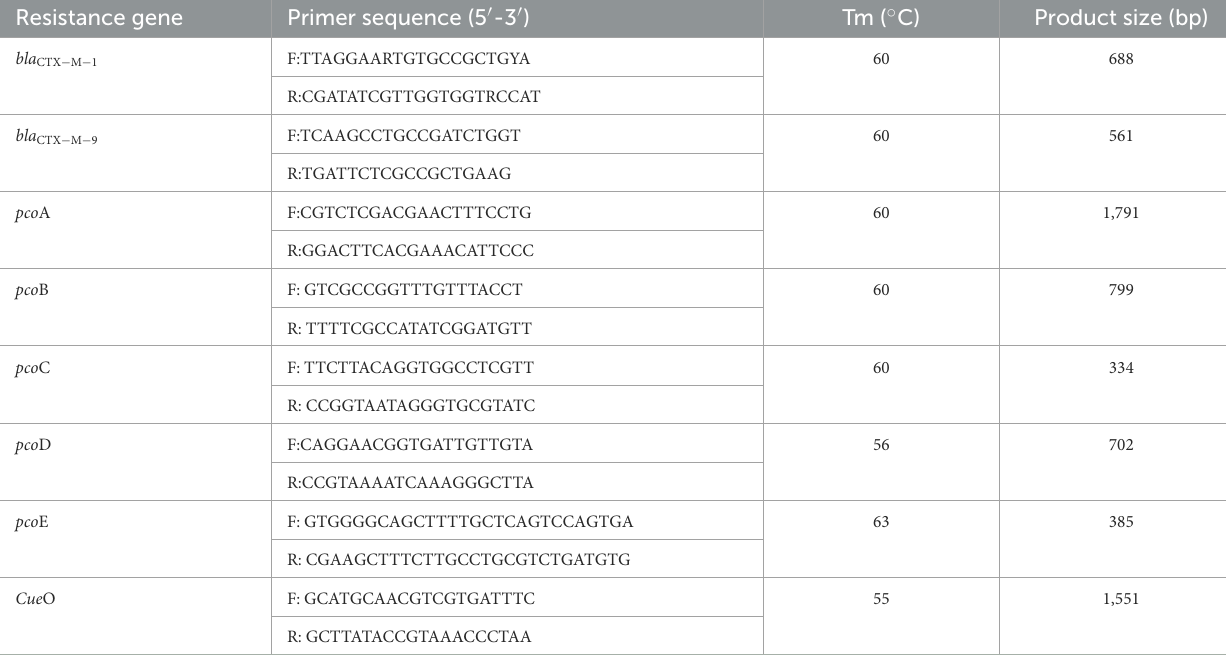
TABLE 1 Primer sequence of PCR.